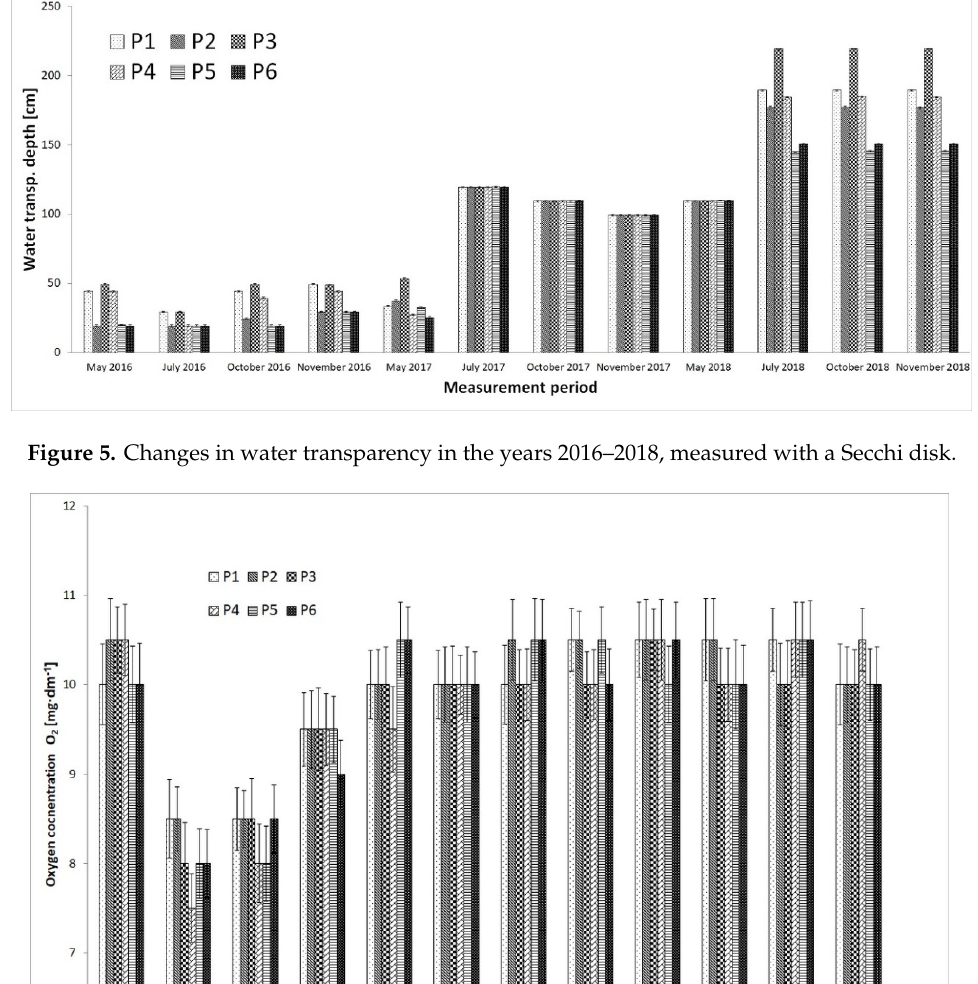
Figure 4. Changes in the thickness of bottom sediments in 2016–2018 at points P1–P6. Measurement campaigns 2016–2018.